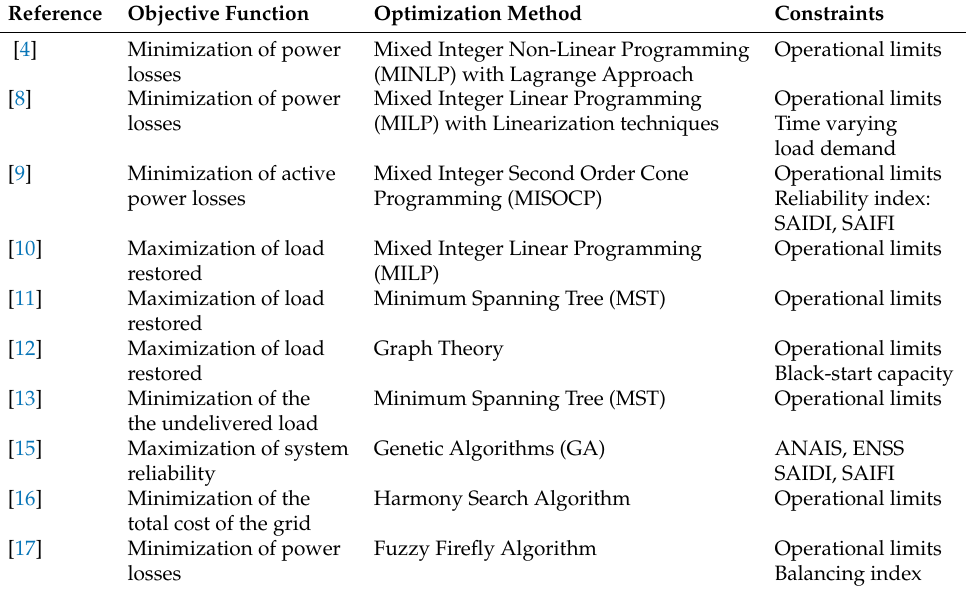
Table 1. Distribution network reconfiguration literature